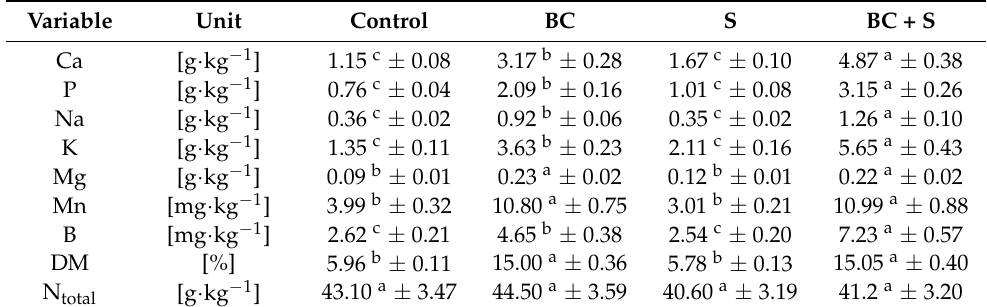
Table 5. Properties of activated digestates (in fresh matter): BC—biochar, S—sulphur, BC + S—biochar and